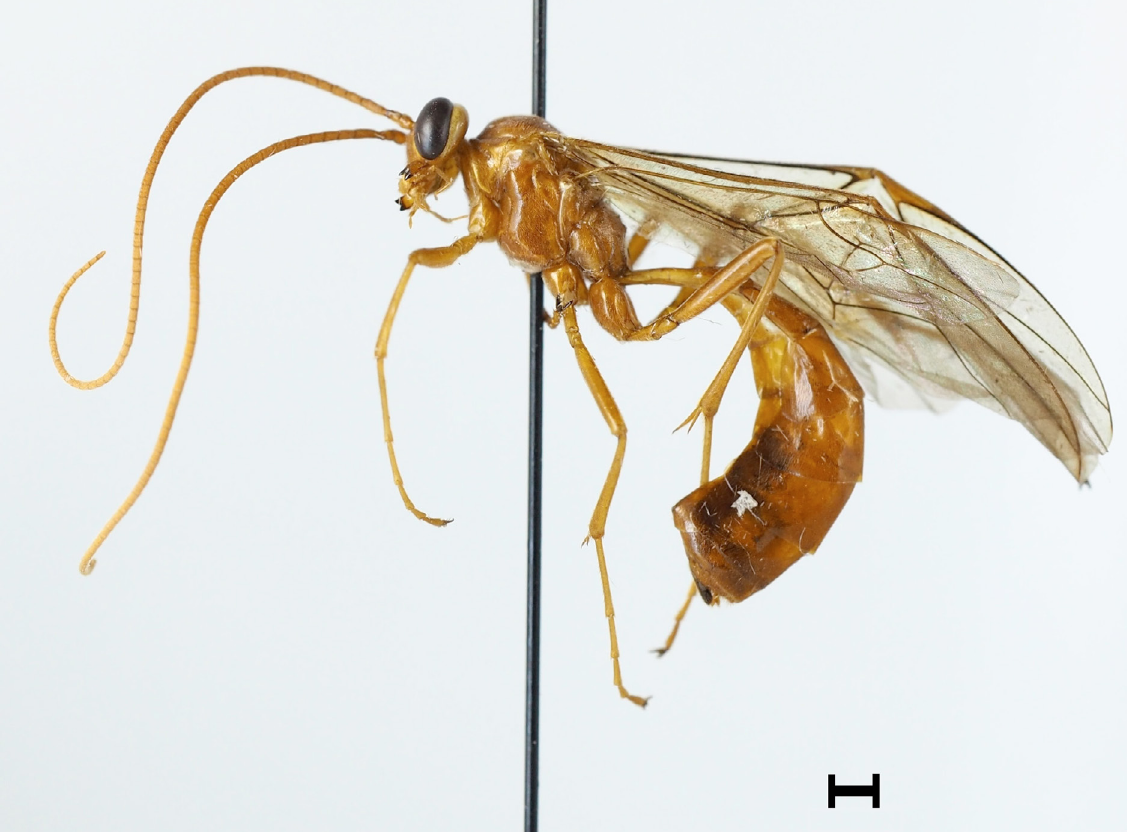
Fig. 41. Ophion splendens Johansson sp. nov., paratype, ♀ (NHRS-HEVA000008708). Scale bar = 1